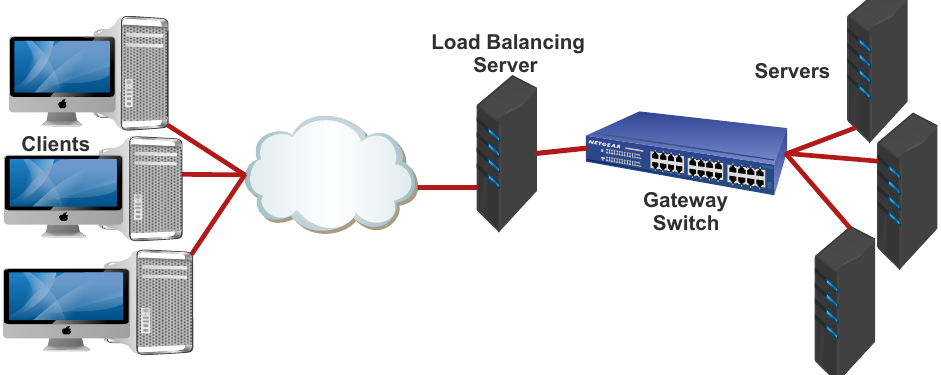
Figure 1. Traditional IP network load balancing